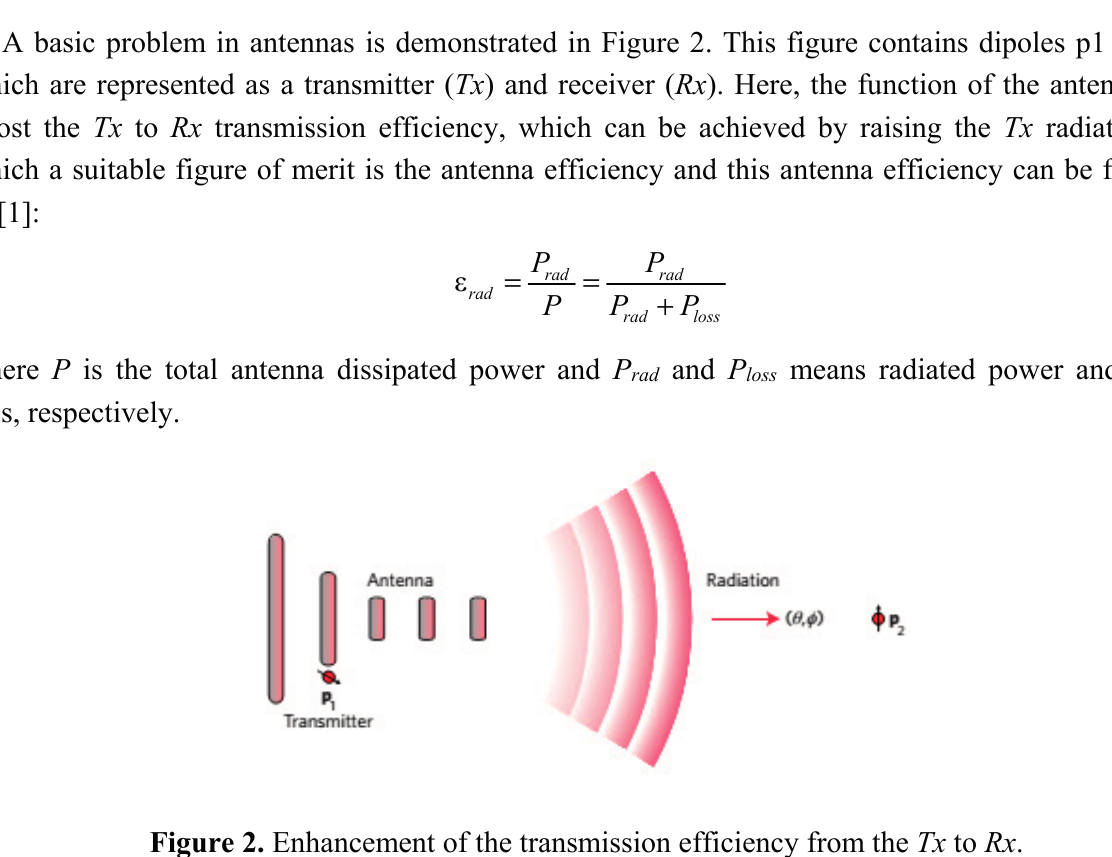
Figure 2. Enhancement of the transmission efficiency from the Tx to Rx